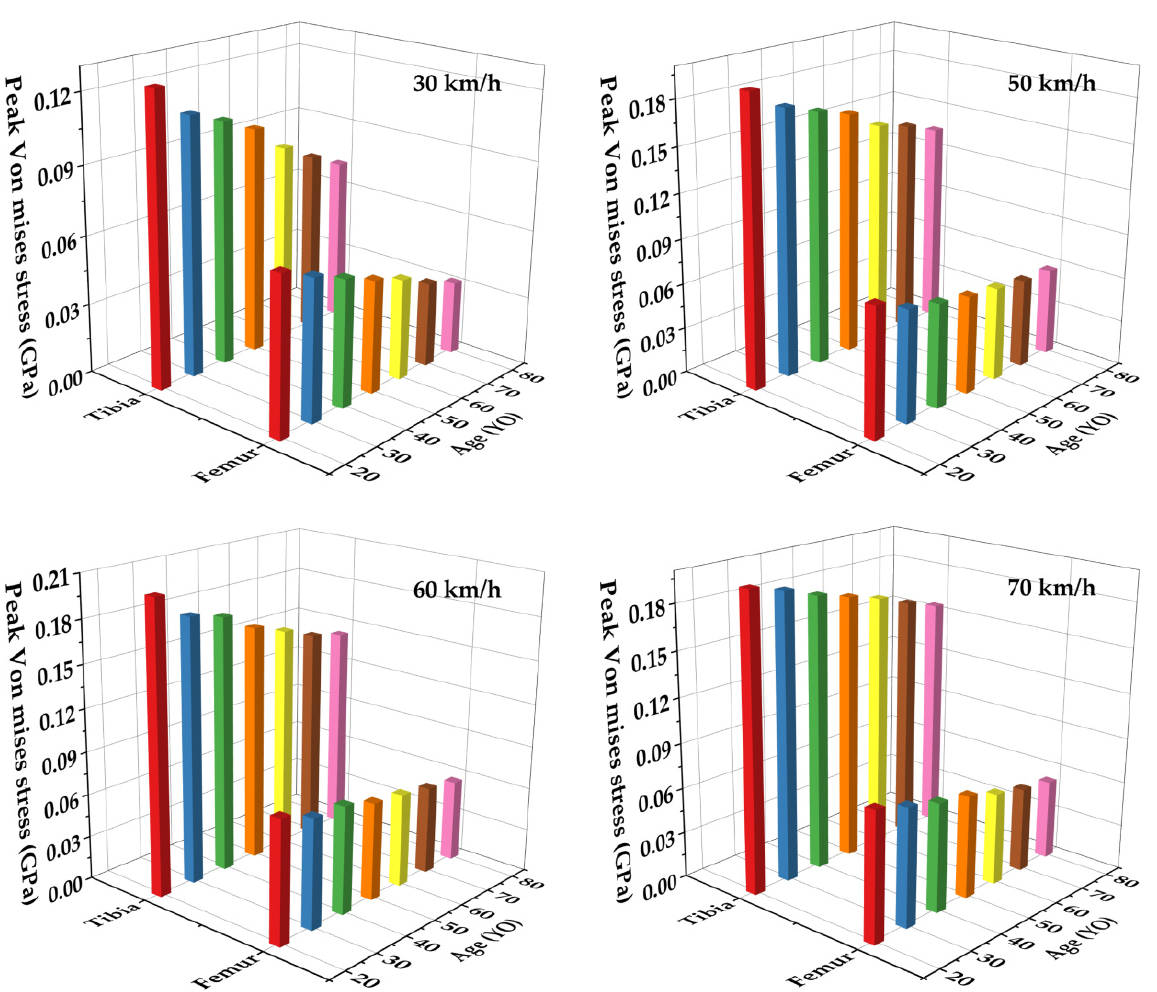
Figure A5. Bending moment of femur and tibia of pedestrians of seven ages at 70 km/h.